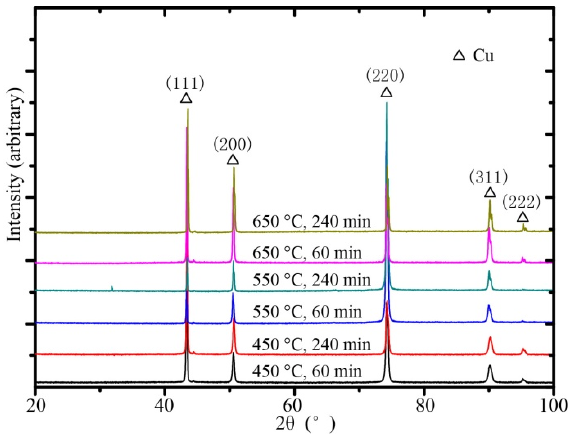
Figure 7. XRD patterns of annealed Cu–Cr–In samples.